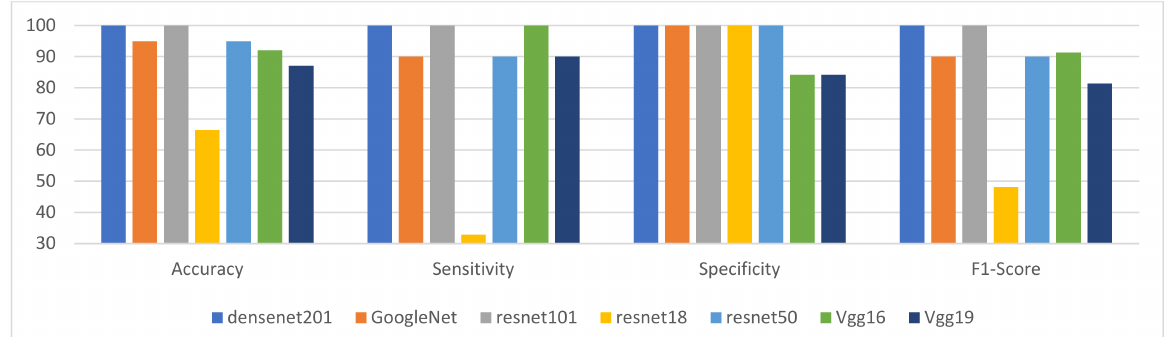
Figure 5. Comprehensive view on DDSM dataset of the effect of the different CNN models using best value of K.